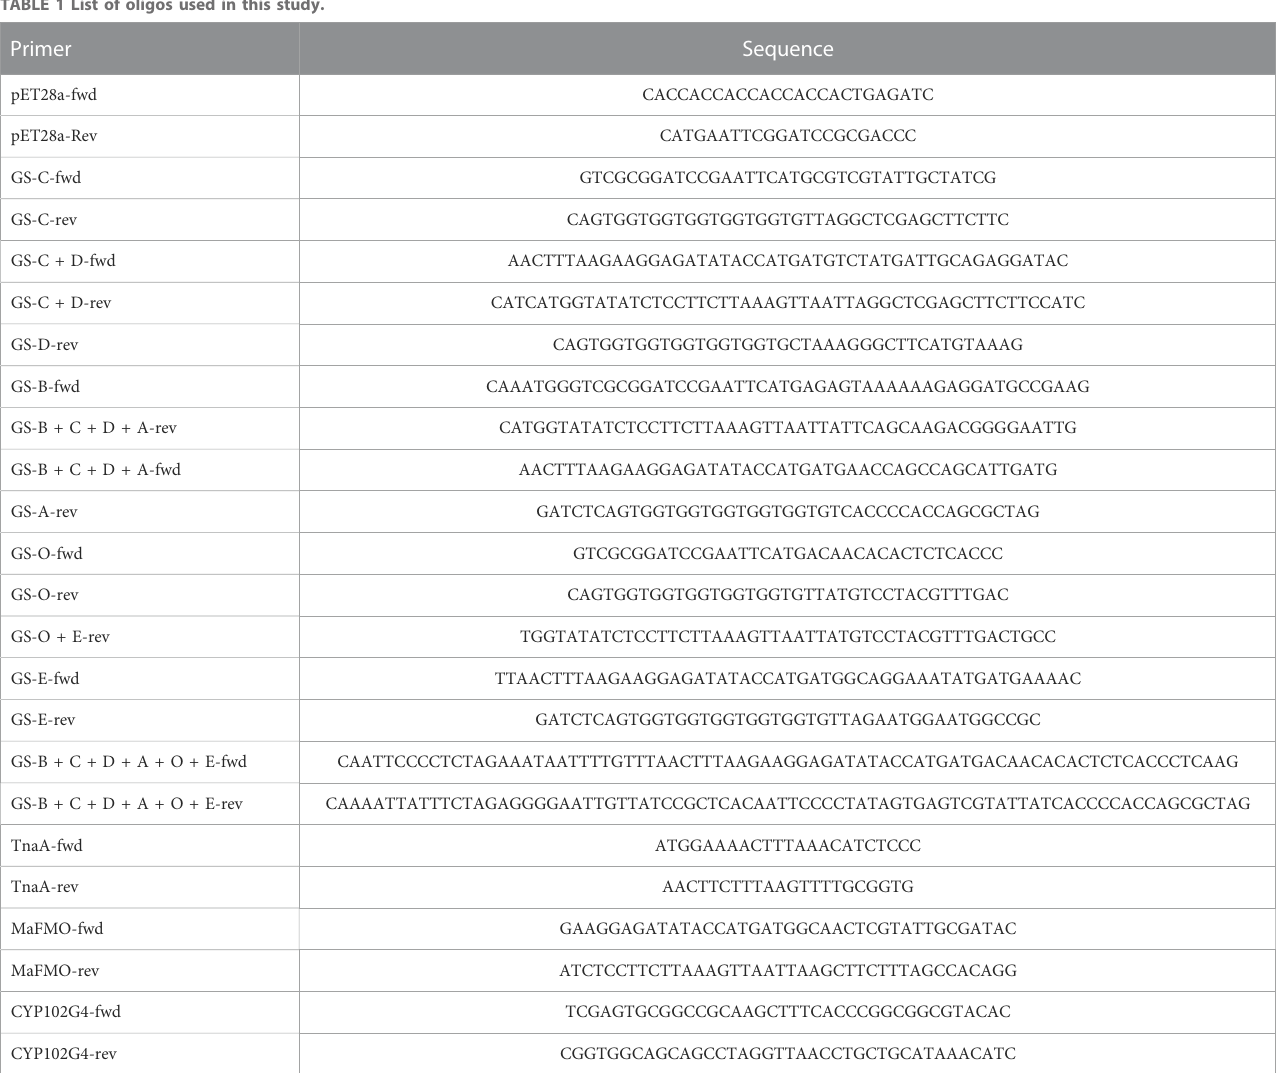
TABLE 1 List of oligos used in this